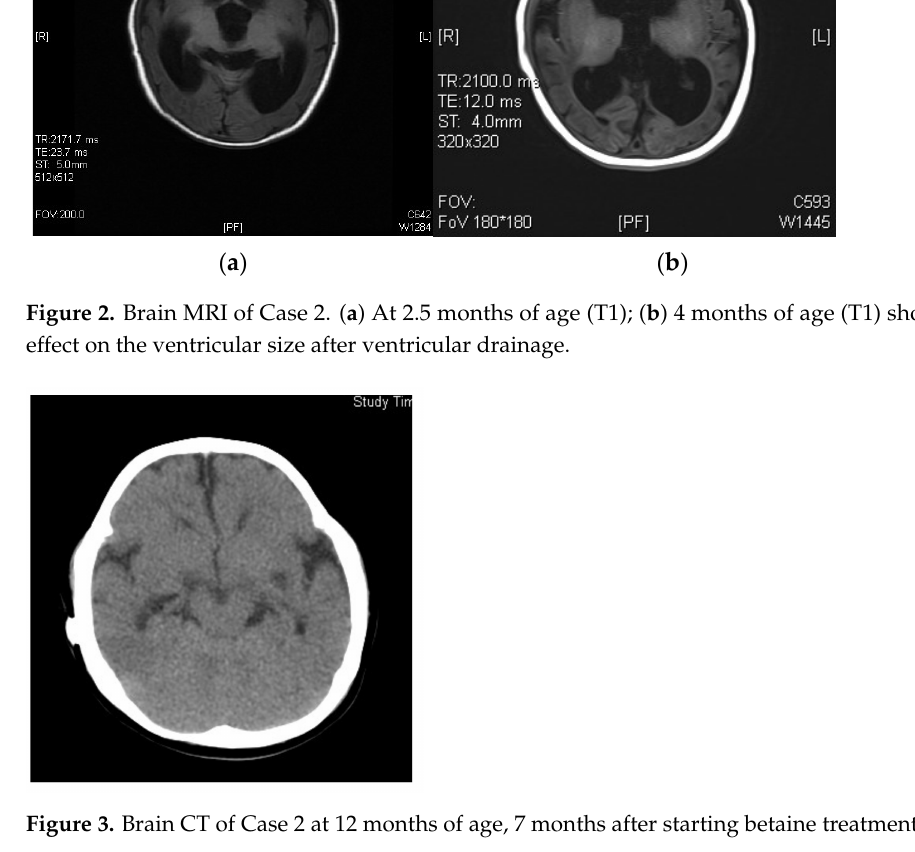
Figure 3. Brain CT of Case 2 at 12 months of age, 7 months after starting betaine treatment.